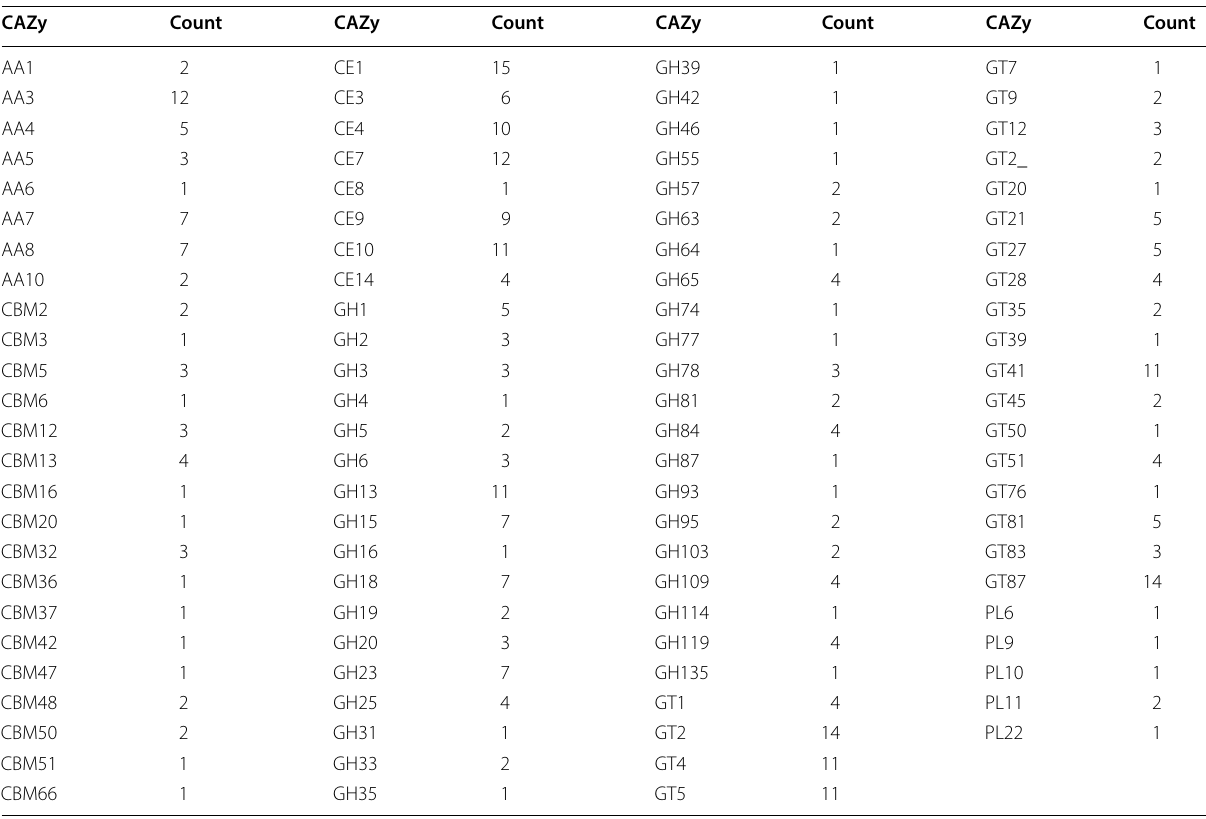
Table 3 Carbohydrate-active enzyme counts of Streptomyces diastaticus CS1801